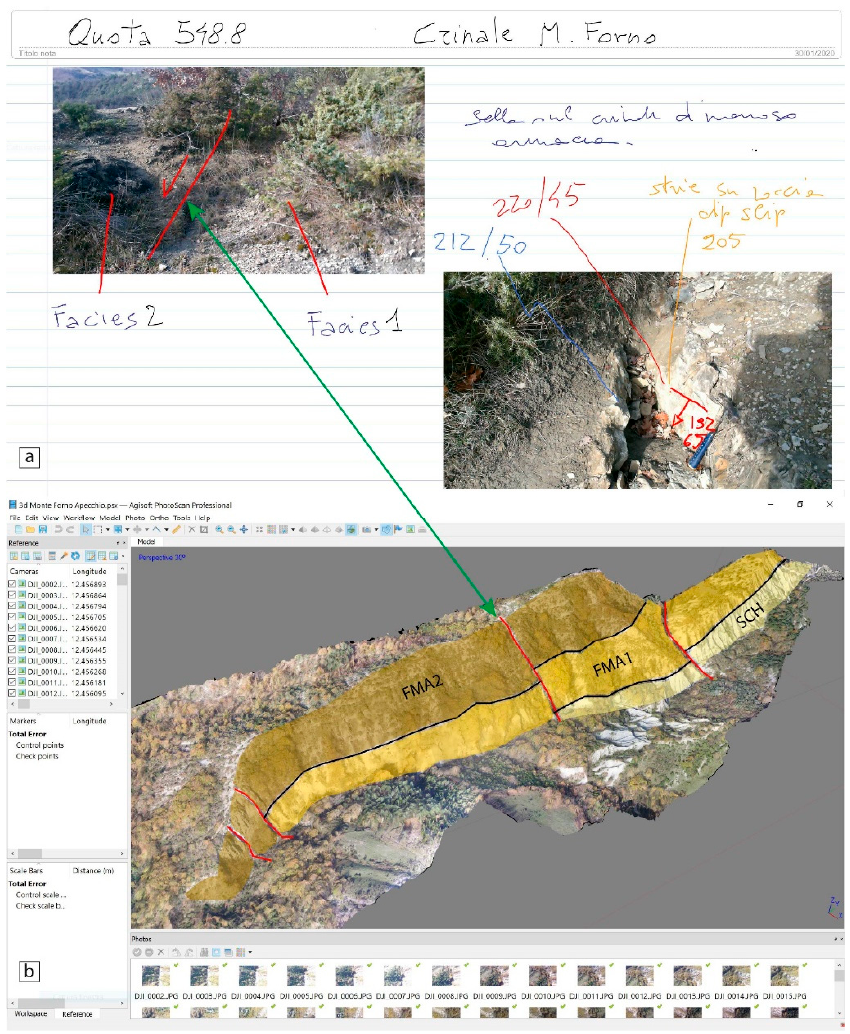
Figure 10. ( a ) Windows Journal note of Monte Forno (A5 site; see Figure 2 for location) with interpreted pictures of local measurements; ( b ) virtual outcrop along the Monte Forno stream with fault traces and interpreted stratigraphy (SCH, marls of the Schlier Formation; FMA1, thin-bedded turbidite facies of the Marnoso Arenacea Formation; FMA2, thicker arenaceous layer facies of the Marnoso Arenacea Formation). The green arrow shows the site of the fault data measurements.